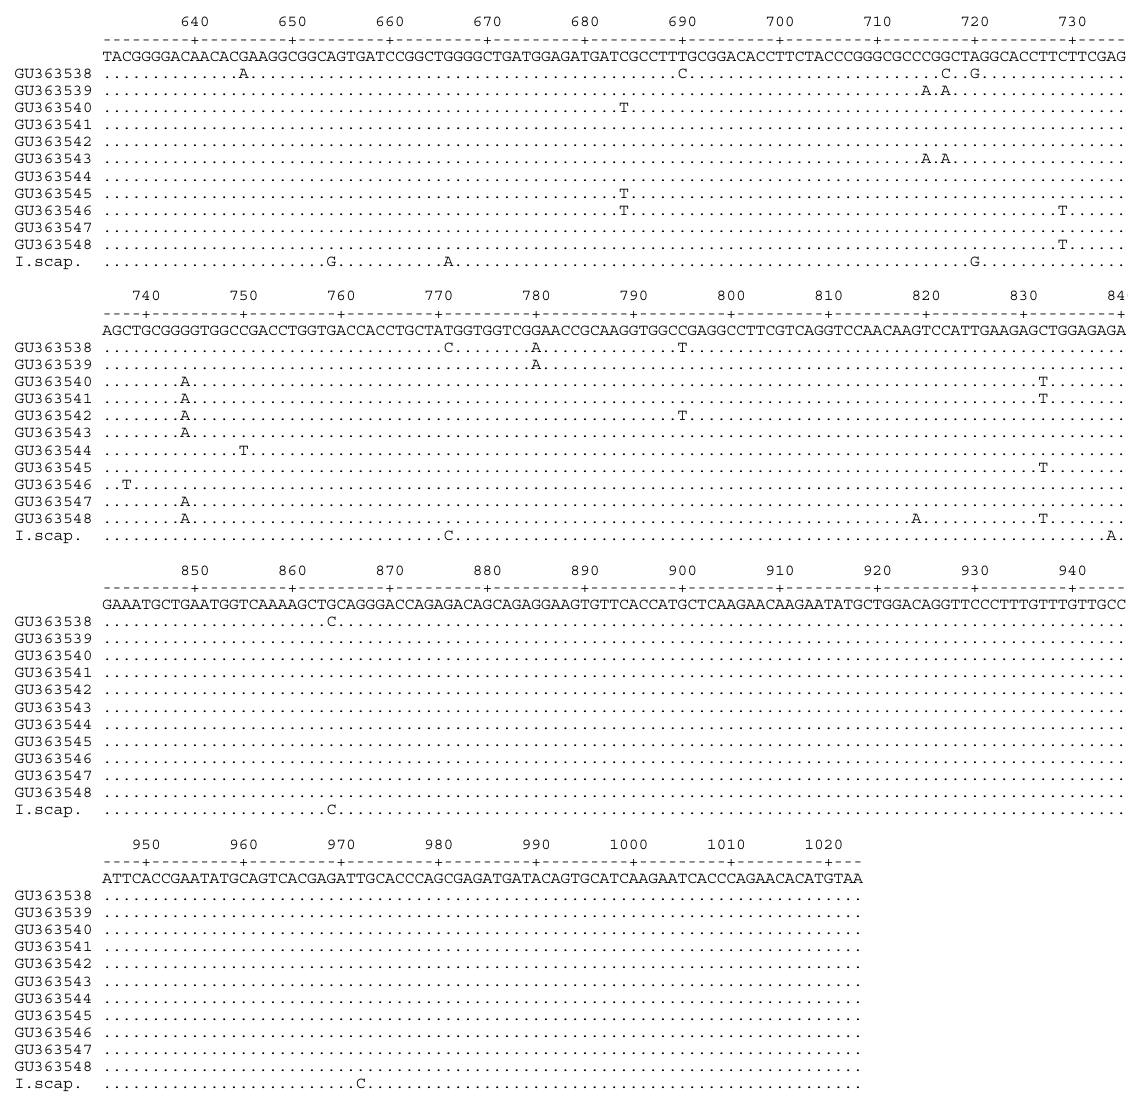
Fig. 1. – Alignment of 1,023 bp long coding sequences of Ixodes ricinus gene encoding glycerol-3-phosphate dehydrogenase, completed with corresponding sequence of Ixodes scapularis (accession number – XM002434599). It should be noted that primers for sequencing exon regions of I. ricinus Gpdh gene were designed on the basis of I. scapularis Gpdh gene sequence, which implies a possibility of errors in the obtained nucleotide sequences in the terminal primer binding regions (ZR- GPDH-N-F and ZR-GPDH-C-R). This may be important because C-terminal amino acids (glutamine, asparagine and leucine) in the flight muscle specific isoform of